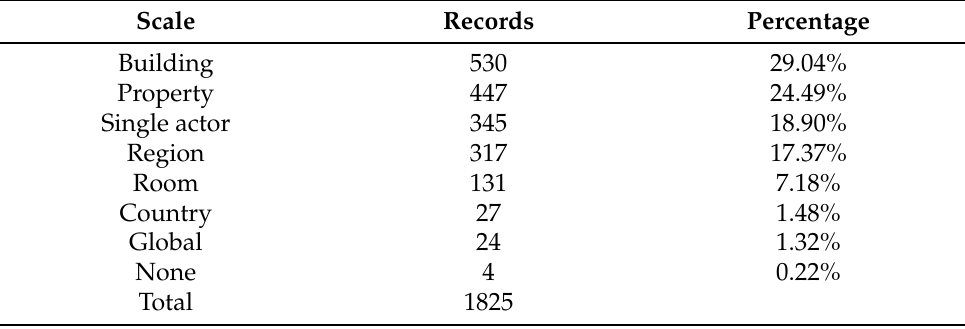
Table 3. Sensor network deployment distribution by scale of the goal